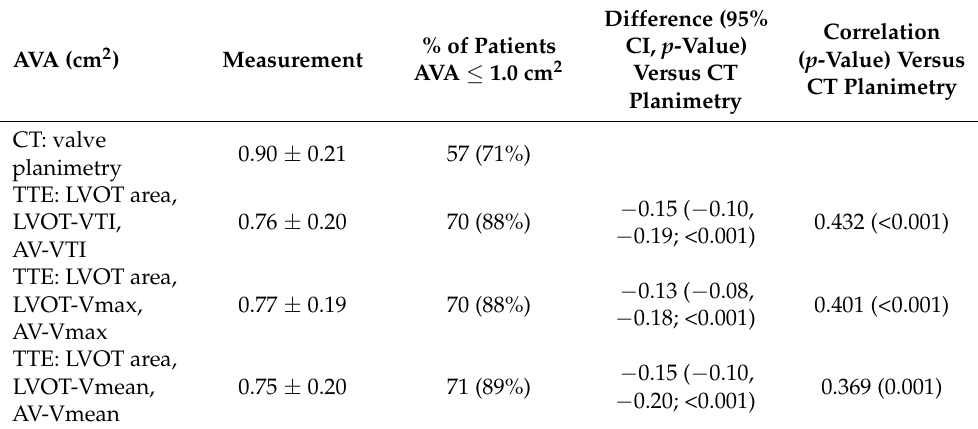
Table 4. Comparisons and correlations between echocardiography and computed tomography estimates of aortic valve